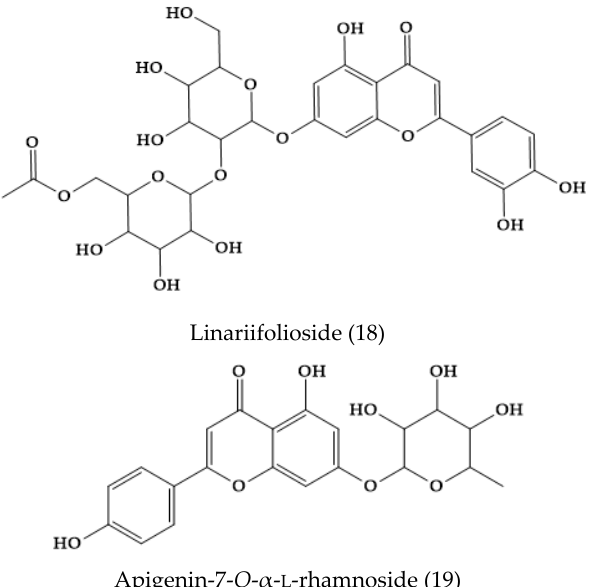
Figure 3. Flavone derivatives found in Veronica filiformis and Veronica linariifolia .